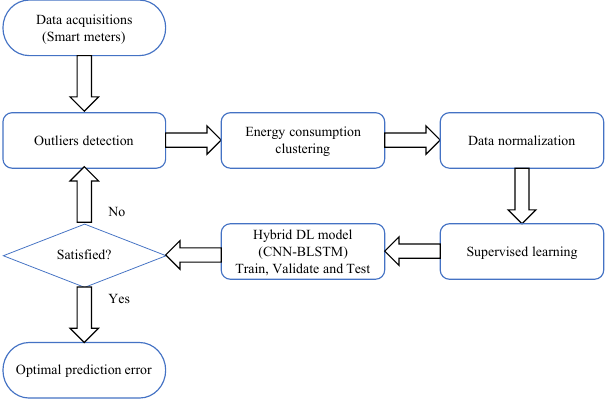
Figure 2. Proposed prediction model